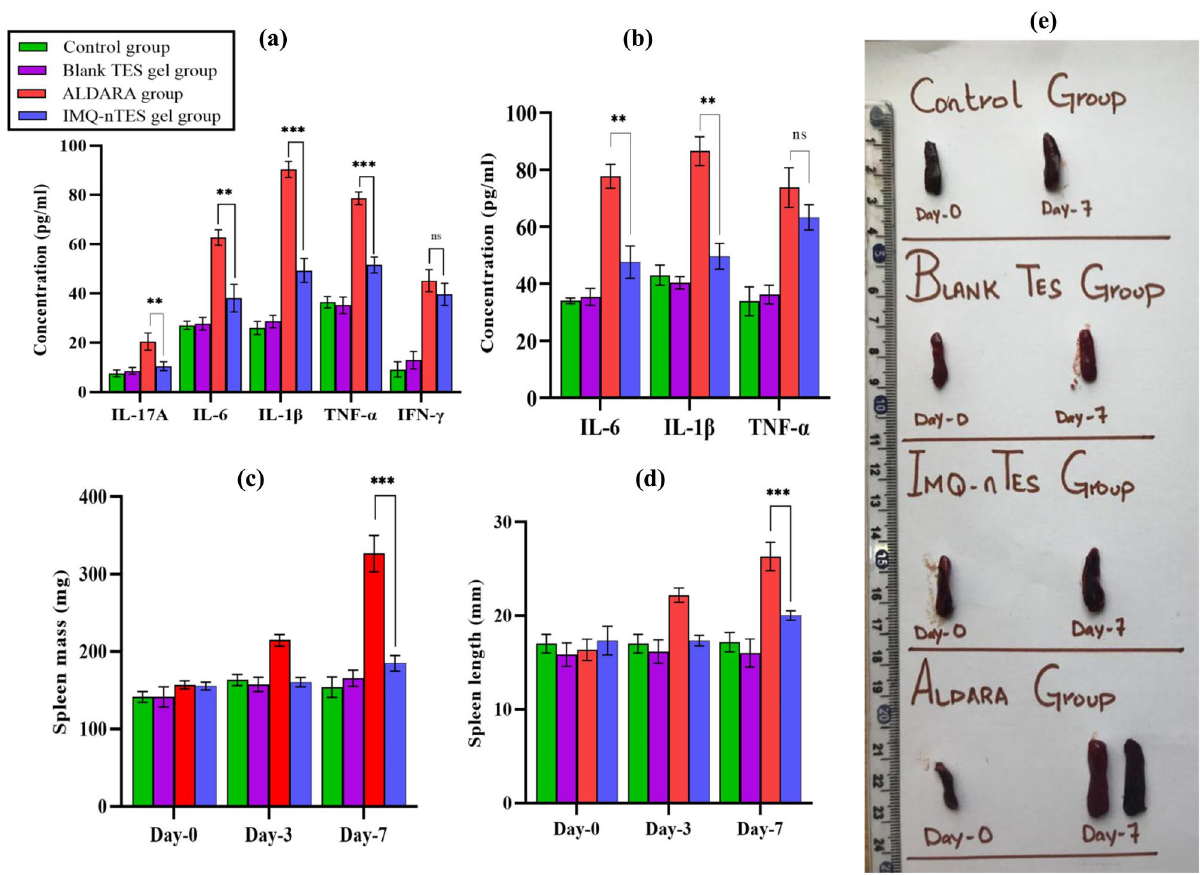
Figure 9. ( a ) Cutaneous cytokines level in ALDRA, IMQ-n TES gel, Blank TES gel and control group (at day-7). ( b ) Serum cytokines level in ALDARA, IMQ-n TES gel, blank TES gel and control group (at day-7). ( c ) Spleen mass in ALDARA, IMQ-n TES gel, blank TES gel and control group; ( d ) spleen length in ALDARA, IMQ-n TES gel, blank TES gel and control group; ( e ) pictorial representation of IMQ induced splenomegaly in in ALDARA and IMQ-n TES gel group. Data is presented as mean ± SD, for each value n = 3; *p < 0.05, **p < 0.01, ***p < 0.001, ns p >